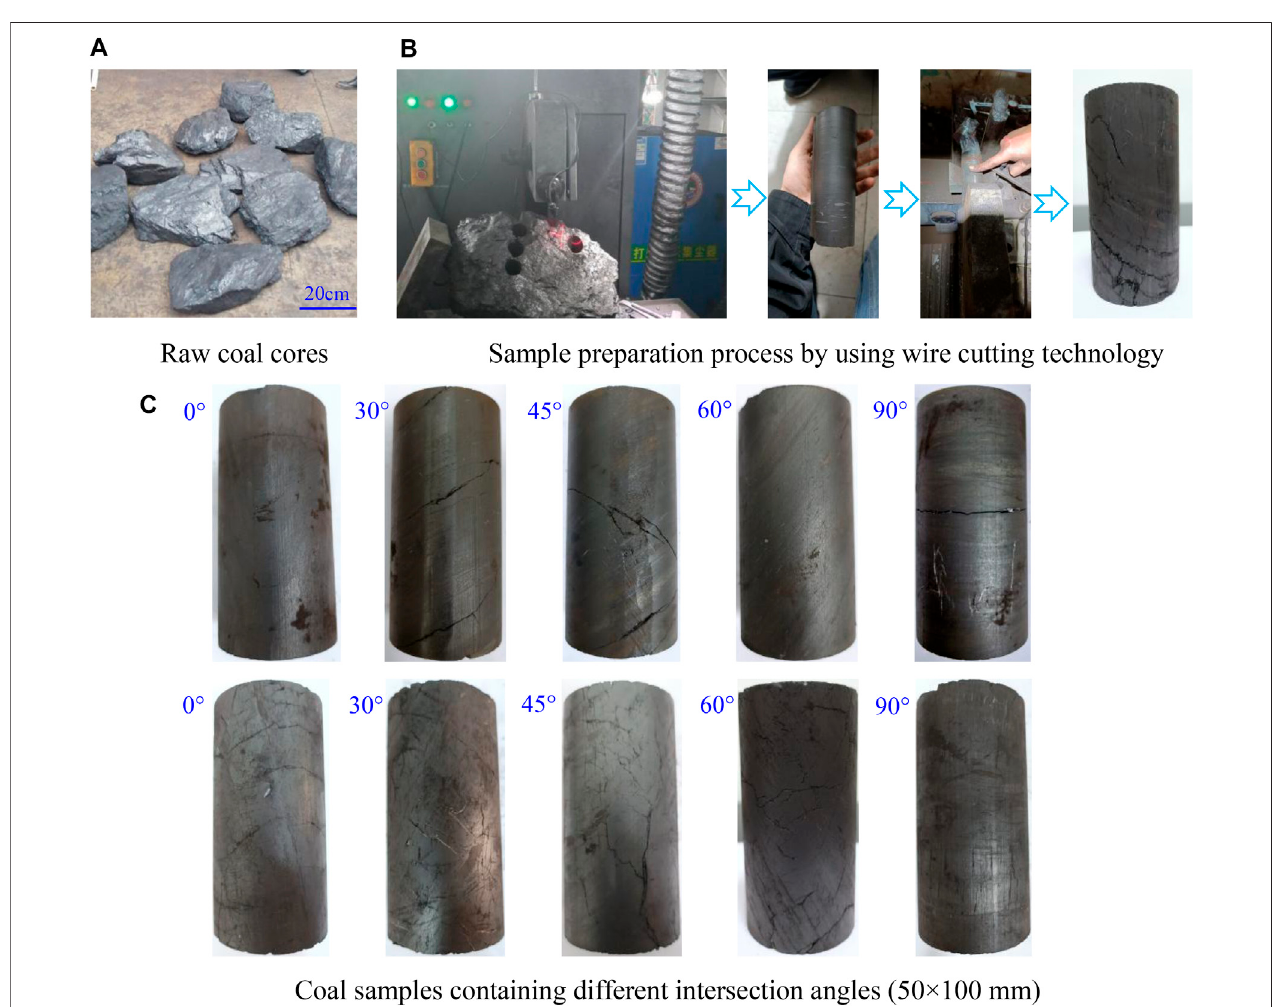
FIGURE2| Coalcoresandsamplesforporosityandpermeabilitytesting. (A) Rawcoalcores (B) Samplepreparation processbyusingwirecuttingtechnology (C) Coal samples containing different intersection angles (50 × 100 mm).